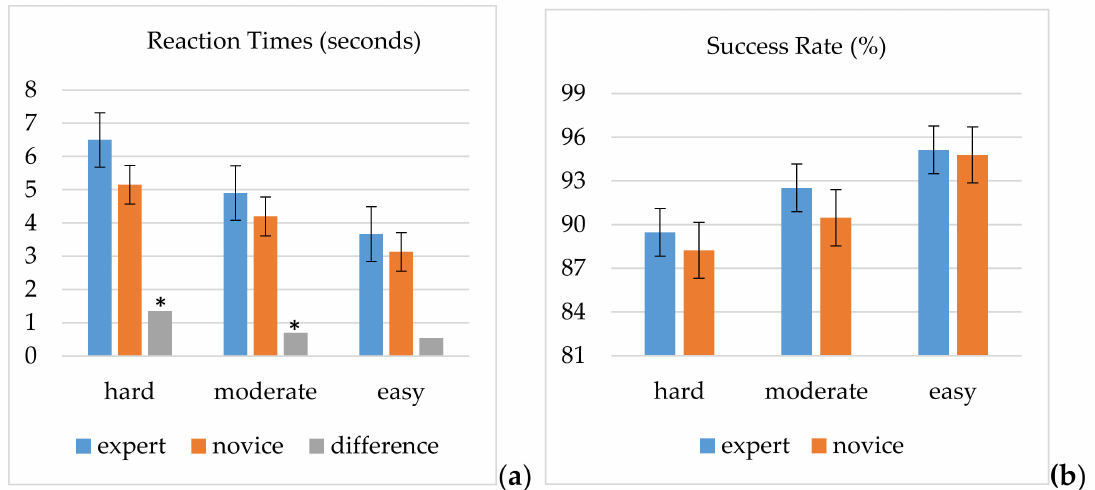
Figure 3. ( a ) Reaction times; ( b ) success rates (* significant di ff